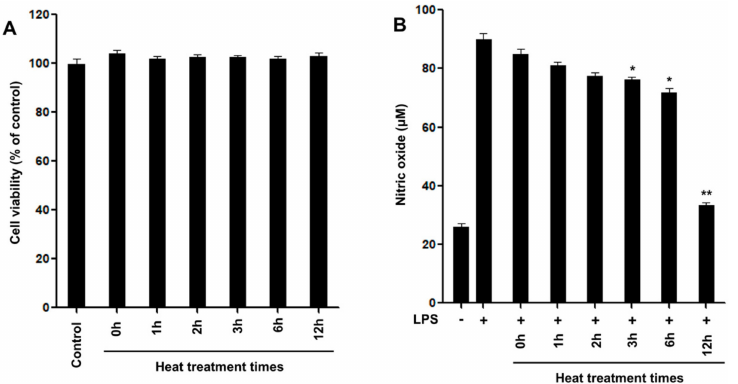
Figure 1. Effects of various thermal treatment reactants (5 µ g/mL) of rotenone on LPS-induced RAW 264.7 cells. ( A ) Cell viability detection by MTT assay in RAW 264.7 cells after treatment with heat reaction products for 24 h. ( B ) The cells were treated with samples for 2 h, followed by treatment with the LPS (0.1 µ g/mL) for 24 h. The nitrite content of culture media was analyzed. The cells non-treated with reaction products and LPS are referred to as the control group. The experiments were conducted in triplicate and the data are expressed as mean ± SD. * p < 0.05, ** p < 0.01 as compared to the LPS-induced